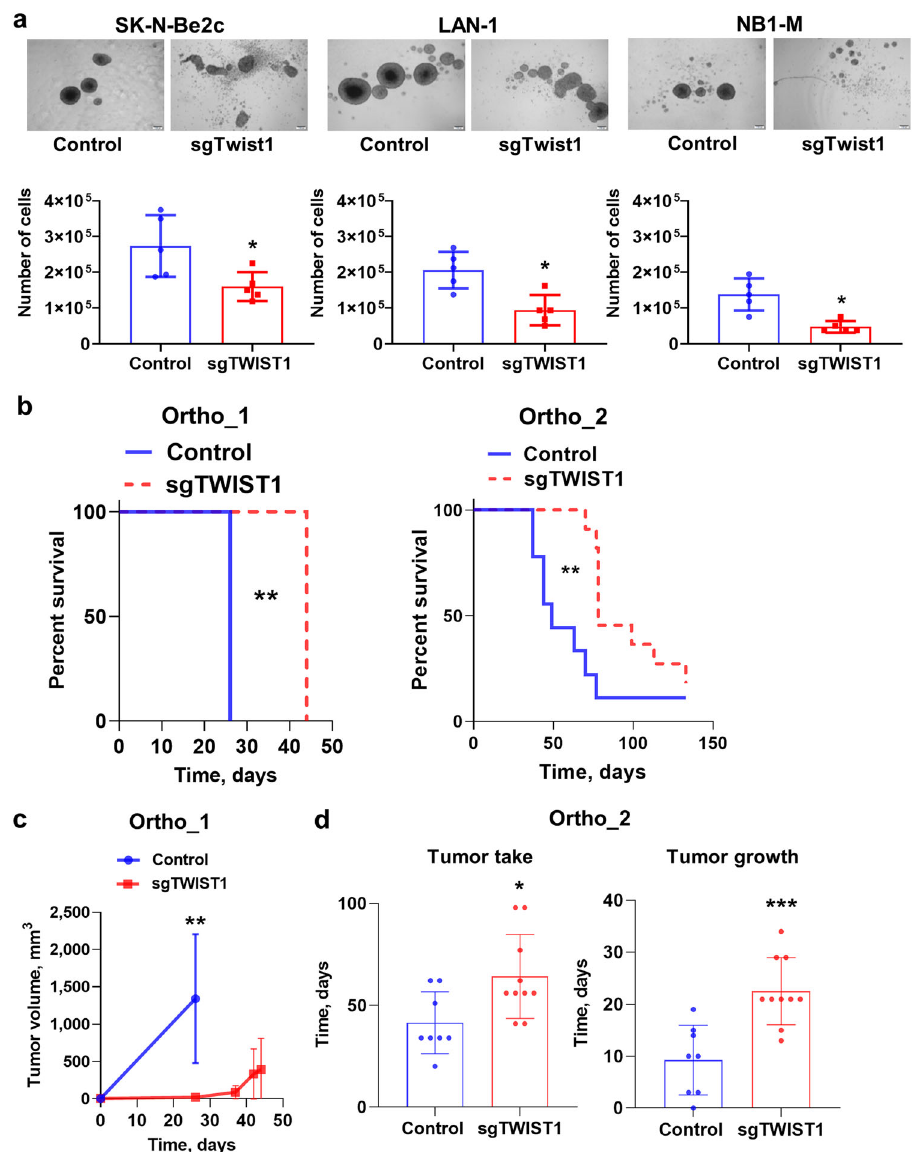
Fig. 2 TWIST1 KO reduces the neurosphere forming capacities of NB cells in vitro and the tumor growth capacities of SK-N-Be2c cells in vivo. a Representative images (scale bar 200 µ m) showing the size and shape of primary neurospheres of Control and sgTWIST1 NB cells after 7 days in culture. The numbers of cells obtained after dissociation of Control and sgTWIST1 primary neurospheres are plotted in bar graphs as individual values for each independent experiments and mean± SD ( n = 5 experiments performed in duplicates). Mann − Whitney test: * p = 0.0317 for SK-N-Be2c; * p = 0.0159 for LAN-1 and NB1-M. b Kaplan − Meier survival curves of athymic Swiss nude mice implanted orthotopically with SK-N-Be2C-Control or -sgTWIST1 cells. Mice were sacri fi ced once tumors reached the volume of 1000 and 500mm 3 for ortho_1 and ortho_2 experiments, respectively. Tumor take: ortho_1: 100% (6/6) in the Control group, 66.66% (4/6) in the sgTWIST1 group; ortho_2: 89% (8/9) in the Control group, 83% (10/12) in the sgTWIST1 group. Median survival in the Control vs sgTWIST1 group: 26 vs 44 days for ortho_1 (** p = 0.0027); 49 vs 78 days for ortho_2 (** p = 0.0016). Gehan − Breslow − Wilcoxon test. c Tumor growth (mean tumor volumes ± SD) for ortho_1 experiment. Multiple t-test (HolmSidak, α = 0.05, without assuming a consistent SD): ** p = 0.0037. d Time for tumor initiation and tumor growth in the ortho_2 experiment (individual values for each mice and mean ± SD). Tumor initiation corresponds to the number of days required to measure an AG volume > 10mm 3 (mean Control: 41.38 days, sgTWIST1: 64.10 days, * p = 0.0192). Time for tumor growth was calculated as the number of days at sacri fi ce minus the number of days for tumor initiation (mean Control: 9.25 days, sgTWIST1: 22.50 days, *** p = 0.0006, unpaired